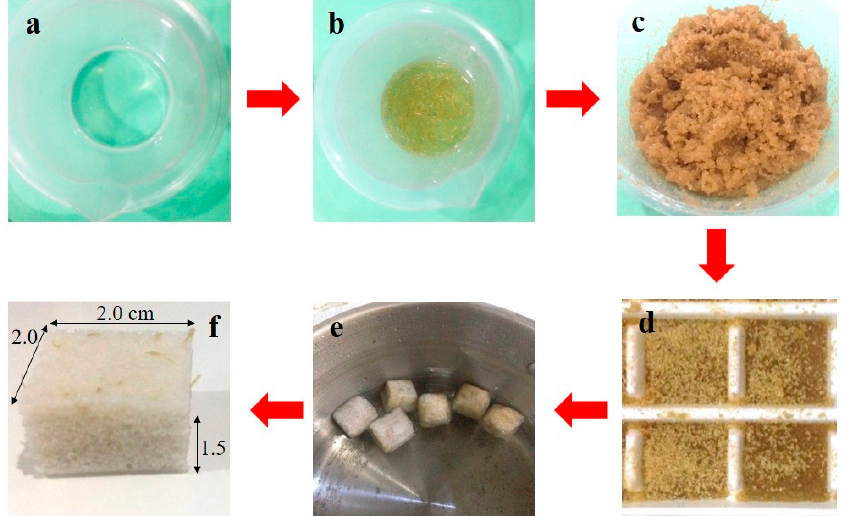
Figure 2. Preparation of bamboo fiber-reinforced polydimethylsiloxane (BF-PDMS) foam involves ( a ) mixing resin and curing agent, ( b ) adding sugar, ( c ) followed by adding bamboo fibers. The mixture was stirred and ( d ) poured into molds, ( e ) followed by boiling, and ( f ) then cut to cuboids of dimensions 2.0 × 2.0 × 1.5 cm 3 .